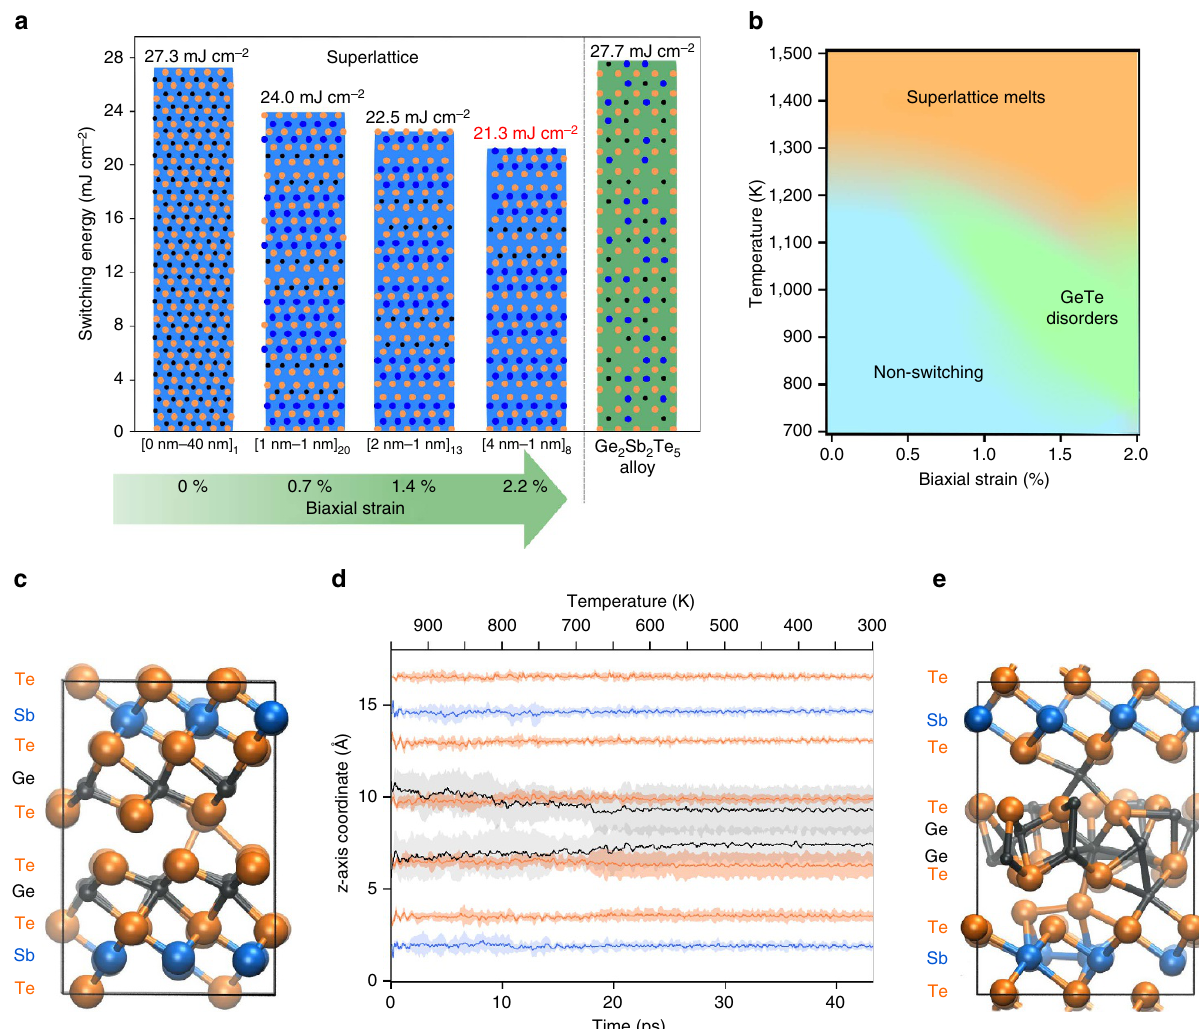
Figure 3 | GeTe disordering. ( a ) The measured minimum laser fluence required to decrease the optical reflectivity of the Sb 2 Te 3 –GeTe vdW superlattices is shown for different thicknesses of the Sb 2 Te 3 layers (blue coloured bars). The biaxial strain in the GeTe layers increases with the Sb 2 Te 3 layer thickness, see Table 1, resulting in a lower threshold fluence to induce disordering in the GeTe layers. The switching fluence required for the Ge 2 Sb 2 Te 5 alloy is also shown (green coloured bar). The dots on the bars illustrate the atomic layer sequence where the Ge, Sb, and Te atoms are coloured black, blue, and orange respectively. ( b ) A strain–temperature map to show the regions where the GeTe and SbTe layers remain stable (blue area), and where diffusive Ge atomic disordering (green area) and superlattice melting (orange area) are likely. GeTe disordering is possible when the superlattice structure is strained. ( c ) The initial (Sb 2 Te 3 , 1nm—GeTe, 1nm) superlattice structure in the resonantly bonded crystalline state. ( d ) The mean z -coordinate evolution of the atoms in each layer during a simulated quench from 950K for the 1.5% strained superlattice structure (two similar quenches from 950 and 1,400K for the 0% strained superlattice are included in Supplementary Figs 7 and 8, and supporting information is given in Supplementary Note 4). The solid lines show the mean position of the nine atoms in each layer where Ge, Sb and Te atoms are coloured black, blue and orange, respectively. The semitransparent shading indicates the standard deviation, ± s , in the z -coordinate and was calculated according to s ¼ nine atoms in each layer and i is the atom index in the layer. ( e ) The structure after quenching to 300K. The Sb 2 Te 3 layers remain in tack after the quench, whilst diffusive atomic disordering is confined to a 5Å thick two-dimensional layer of GeTe layer. Colours: Ge–black, Sb–blue and